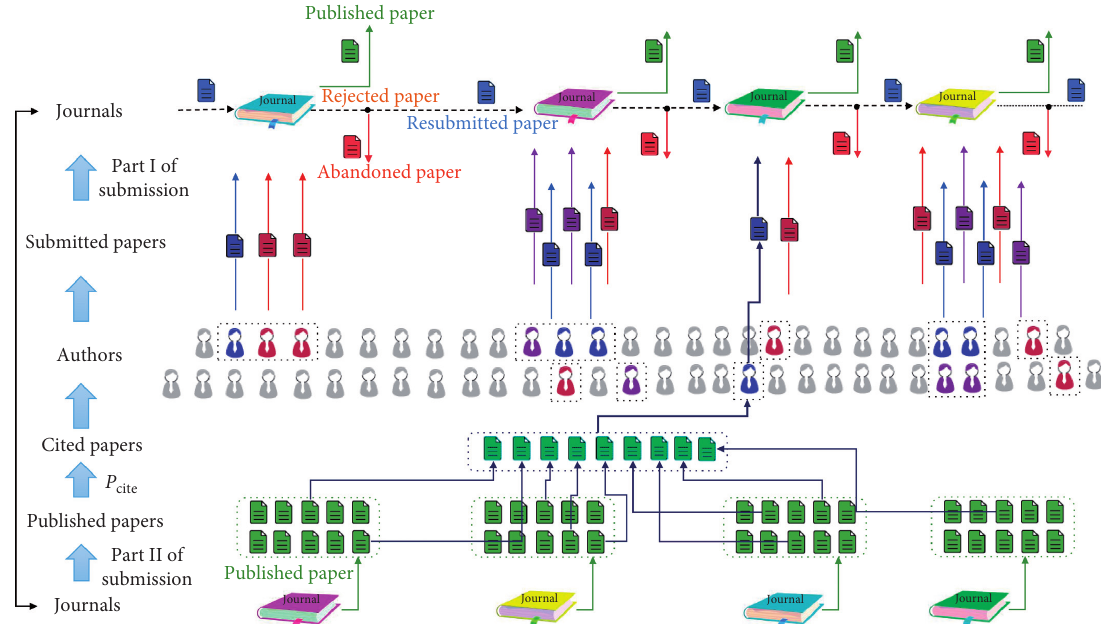
Figure 6: Description of the virtual scientific system. Key features are subsystems of submission and citation. In the submission process, authors select journals for submission based on the submission rules, and journals select papers for publication based on papers’ scores and ranks. In the citation process, the probability of published papers to be cited by submitted papers is exactly determined by P